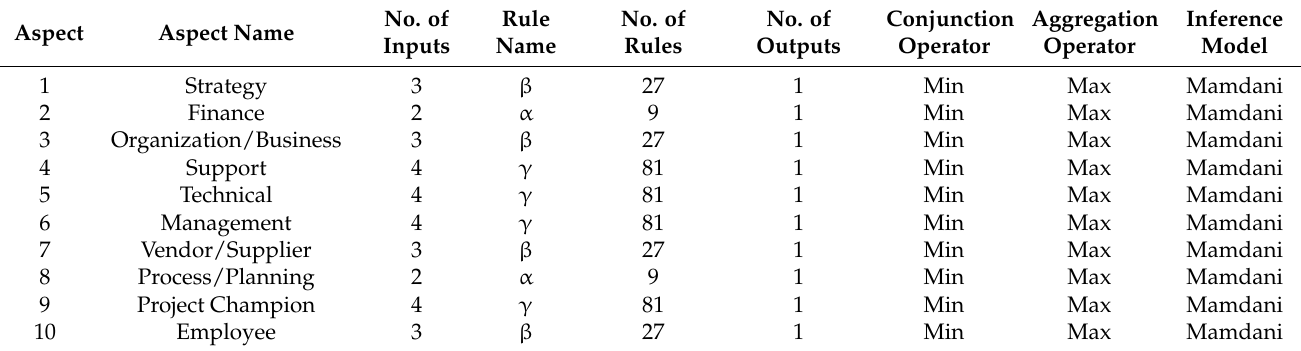
Table 11. Final scores of the AMT implementation prediction